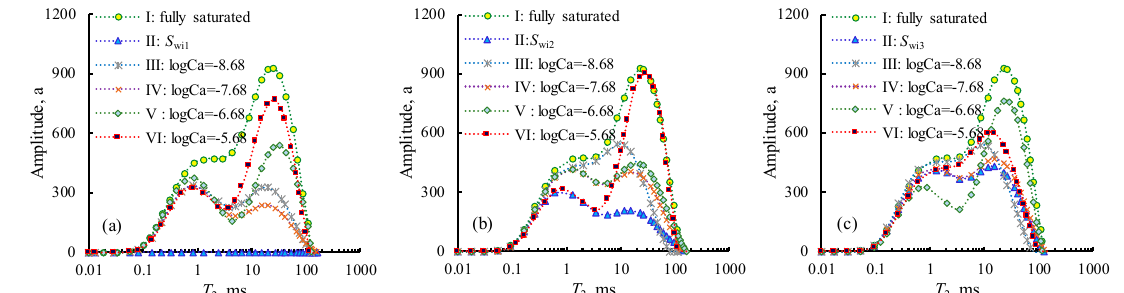
Figure 4. T 2 spectrum of samples #1-1F and #1-2F that measured in the forced imbibition experiments with three S wi and four di ff erent flowrates: ( a ) S wi1 = 0; ( b ) S wi2 = 39.34 ± 1.57%; ( c ) S wi3 = 62.98 ± 2.22%. The curve I and curve II in the above pictures only presents the results of sample #1-1F for concise. (( a ): curves III, IV and VI corresponding to sample #1-2F, curve V corresponding to sample #1-1F; ( b ): curves III, IV, V corresponding to sample #1-1F, curve VI corresponding to sample #1-2F; ( c ) curves III, IV, VI corresponding to sample #1-1F, curve V corresponding to sample #1-2F).